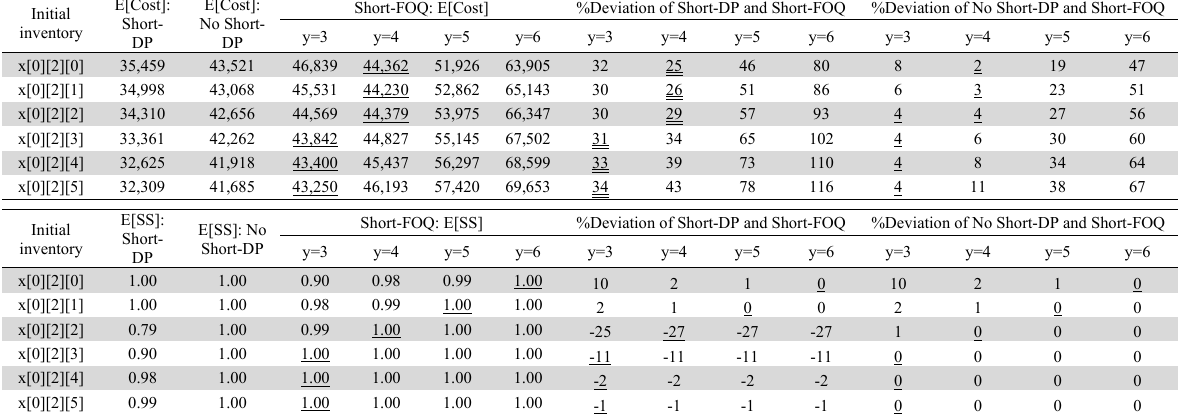
Comparison of the optimal policy (in THB) given the initial stock, and Short-FOQ with and without shortage